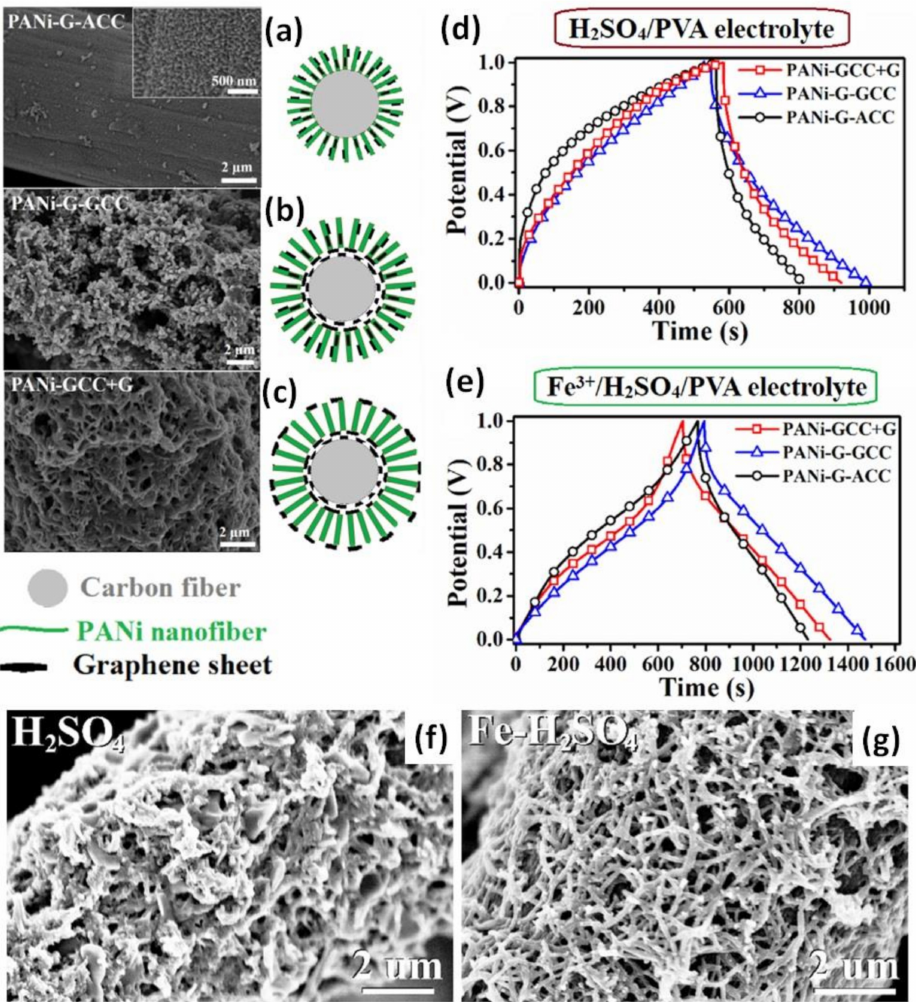
Figure 10. SEM images (left) and schematic view (right) for three kinds of PANI with graphene on carbon cloth with different spatial distribution of graphene sheets: aniline was mixed with graphene oxide before electropolymerization onto carbon cloth (PANI-G-ACC) ( a ), PANI was polymerized onto carbon cloth with already deposited graphene (PANI-G-GCC) ( b ) and additional graphene was deposited onto already prepared PANI/rGO/CC (PANI-GCC+G) ( c ). GCD curves at the current density of 5 mA/cm 2 for the supercapacitors assembled with three kinds of the composite electrodes by using H 2 SO 4 /PVA ( d ) and Fe 3+ /H 2 SO 4 /PVA electrolytes ( e ) (Reprinted from [67], Copyright 2022, with permission of Elsevier). SEM images for PANI on CC with already deposited graphene tested after 3000 cycles in the electrolyte without ( f ) and with 15 mol. % Fe 3+ ion content ( g ) (Reprinted from [68], Copyright 2020, with permission of